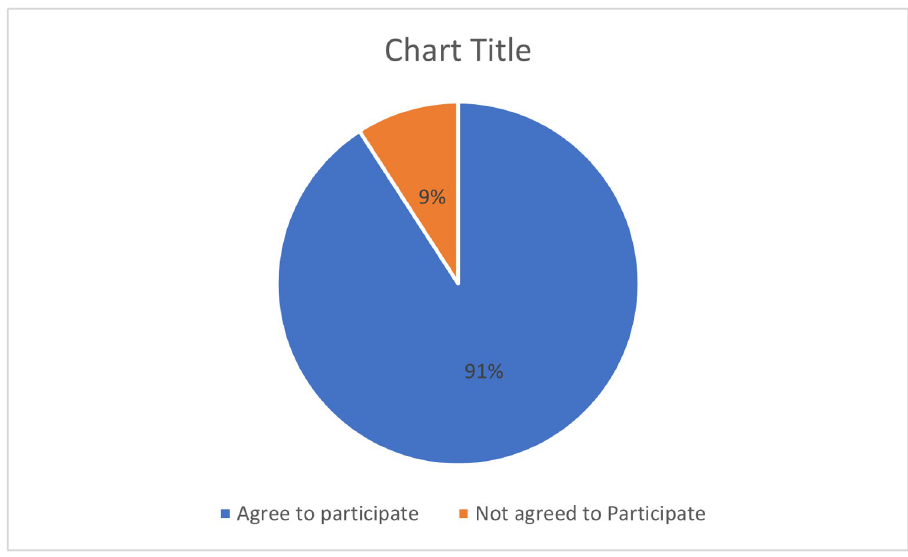
Fig 1. Response rate of the